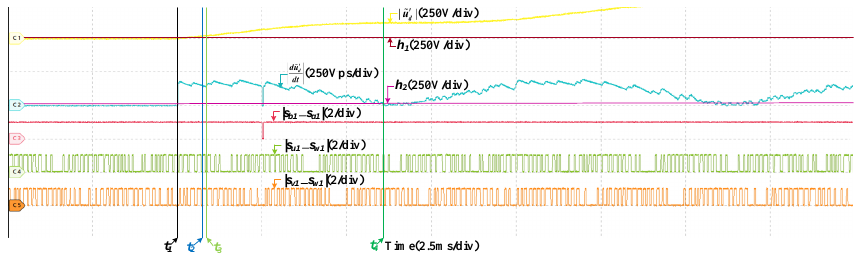
Figure 13. HIL results when the scaling fault occurs in S Cn at 300 km/h.